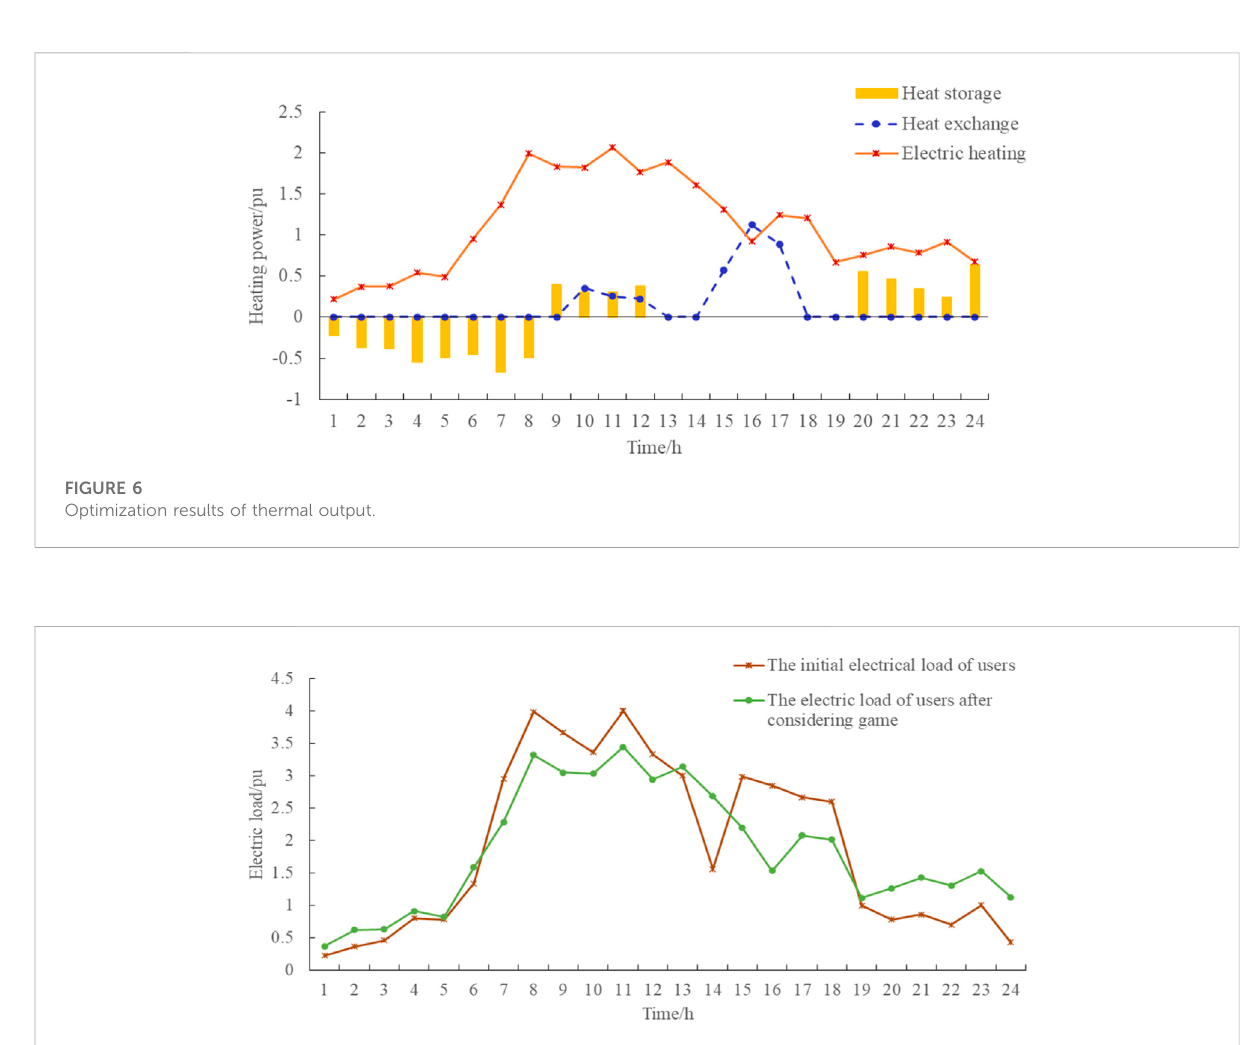
FIGURE 7 Comparison between the users ’ initial electricity load and the electricity load after considering the